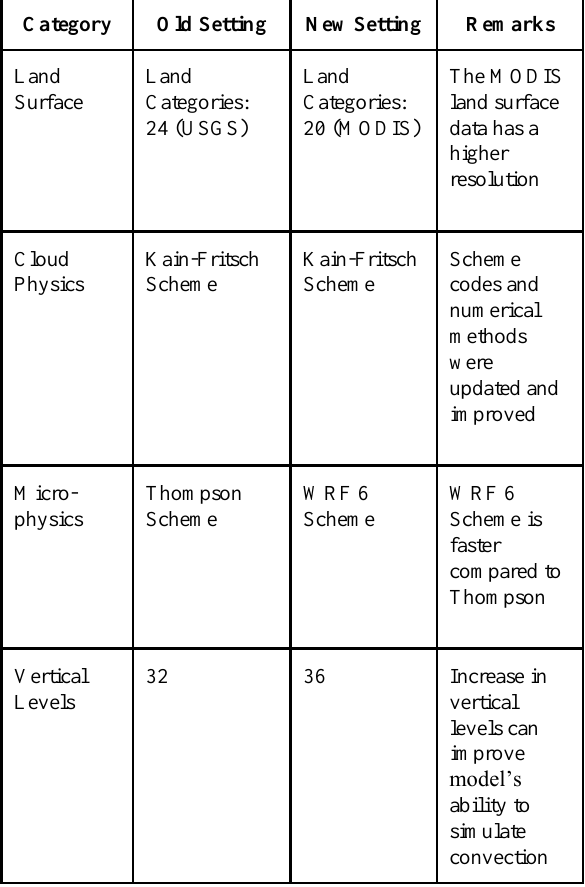
Table 1. Summary of changes made in WRF configuration. The version update improved forecast quality. 2015 forecast were over-forecasted, especially during the onset of the Southwest Monsoon. Error propagation with respect to the